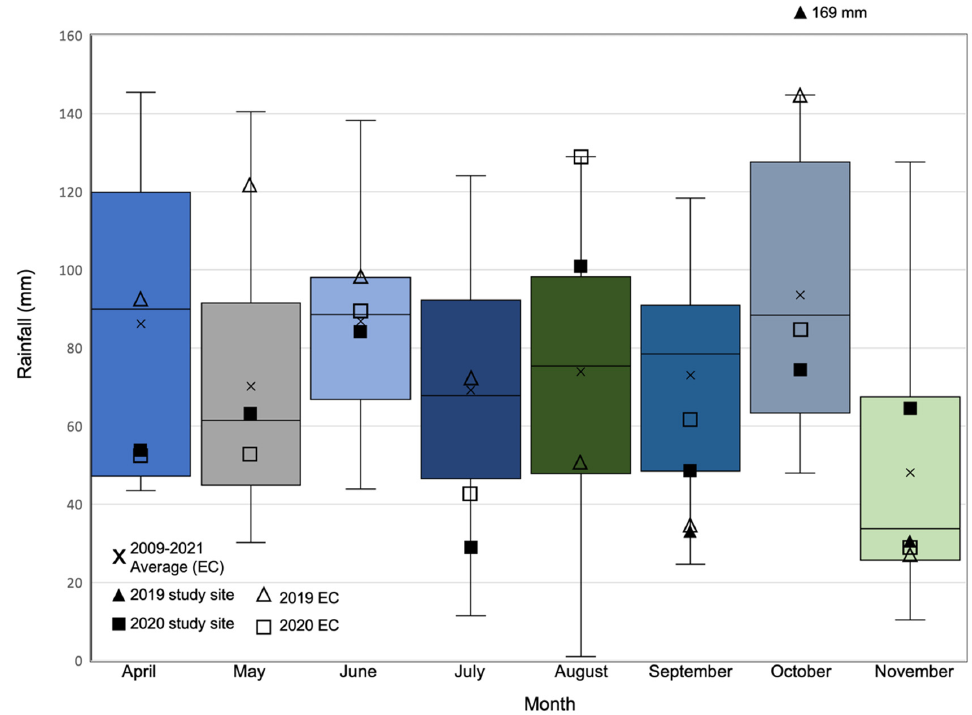
Figure 3. 2009–2021 monthly rainfall totals (x = average) for April–November from a nearby Environment Canada (EC) weather station (ID 6155750), and rainfall totals from the EC record (open symbols) and field site (closed symbols), for 2019 (triangle) and 2020 (square).